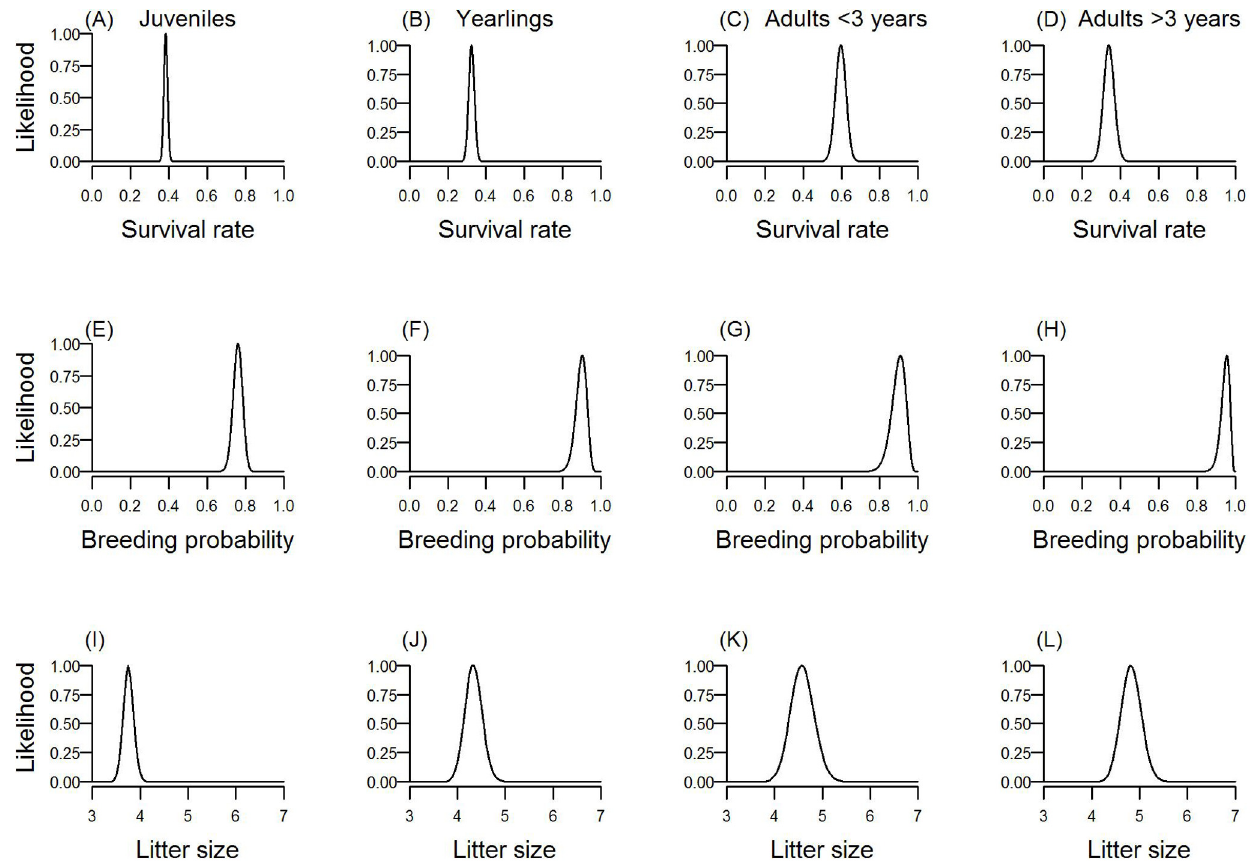
Figure 1. Likelihood distributions for demographic parameters of the hunted Australian population. From left to right for age classes 1 to 4.: (a–d) survival rates ( P x ), (e–h) probability of breeding ( B x ) and (i–l) litter size ( m x ). All likelihoods were rescaled to peak at 1.0.